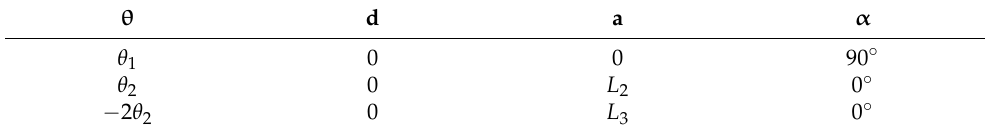
Table 2. D–H parameters of a robot